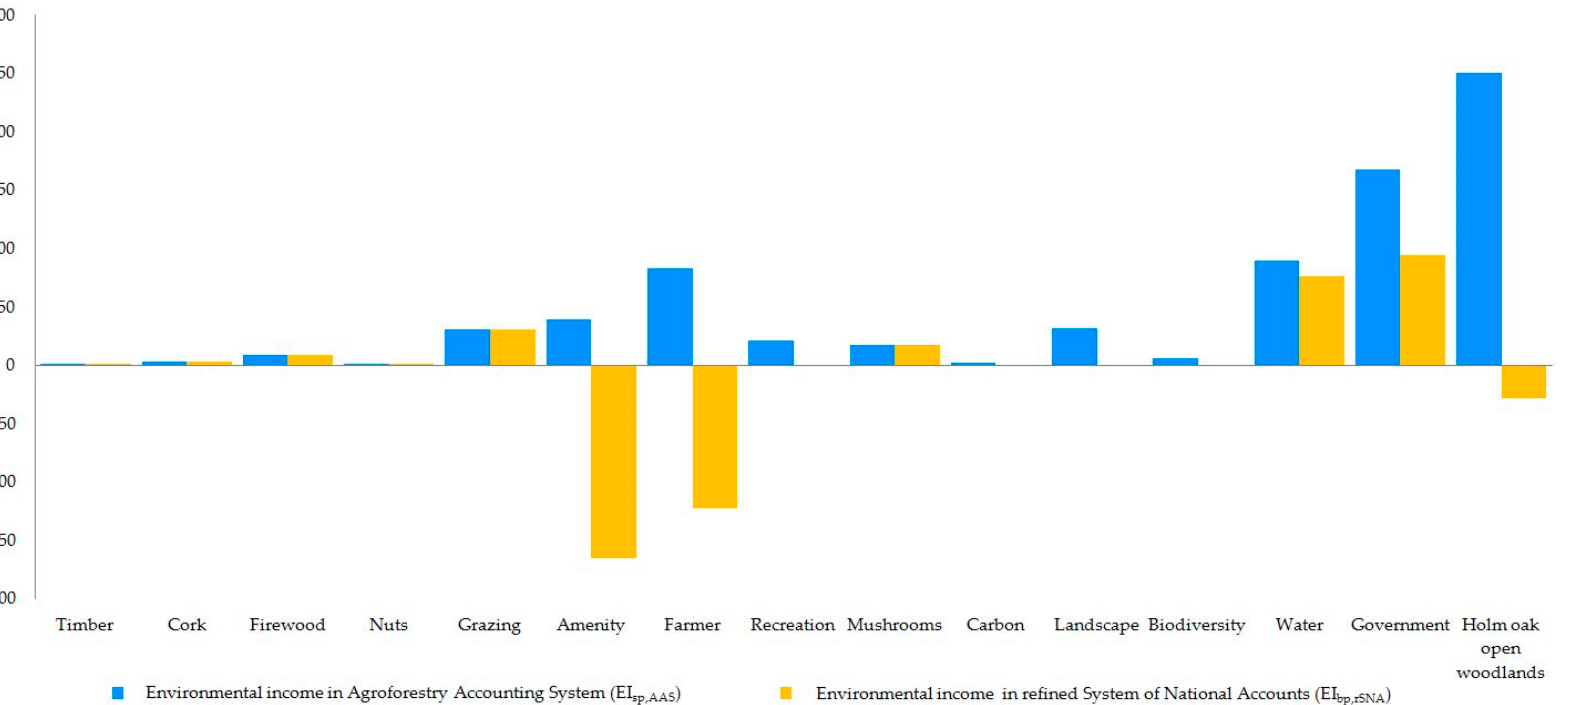
Figure 9. Comparison of AAS and rSNA environmental income at social and basic prices for holm oak open woodlands in Andalusia (2010: €/ha).